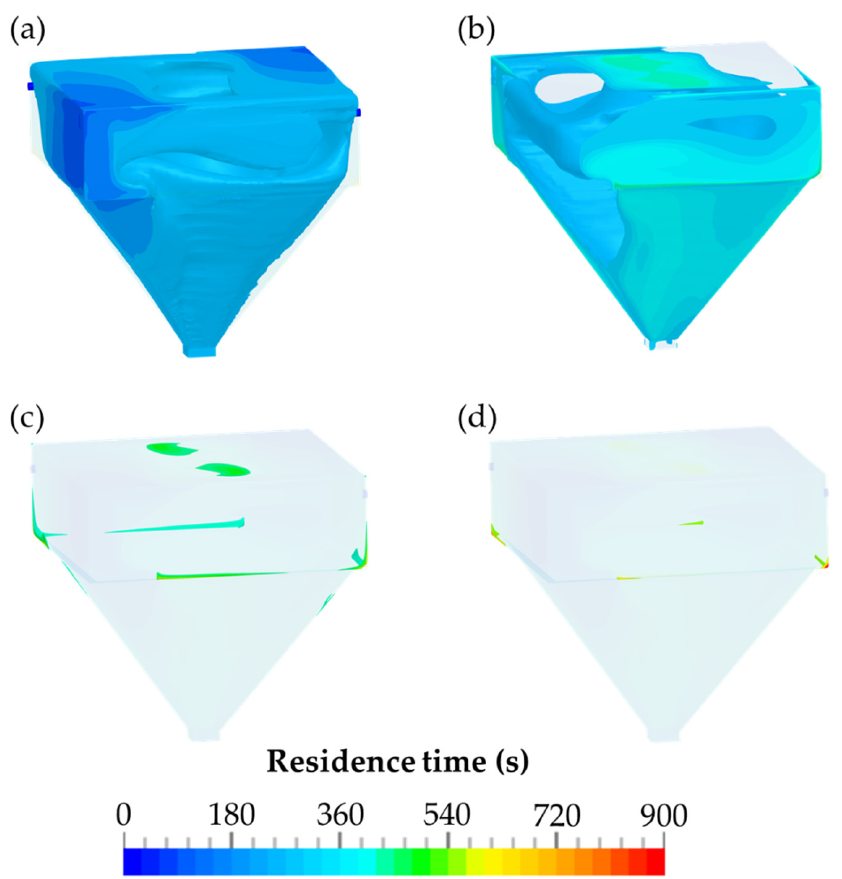
Figure 10. The residence time of the airborne particles within the detection chamber for various time periods: ( a ) 0–180 s; ( b ) 180–360 s; ( c ) 360–540 s; ( d ) 540–900 s.